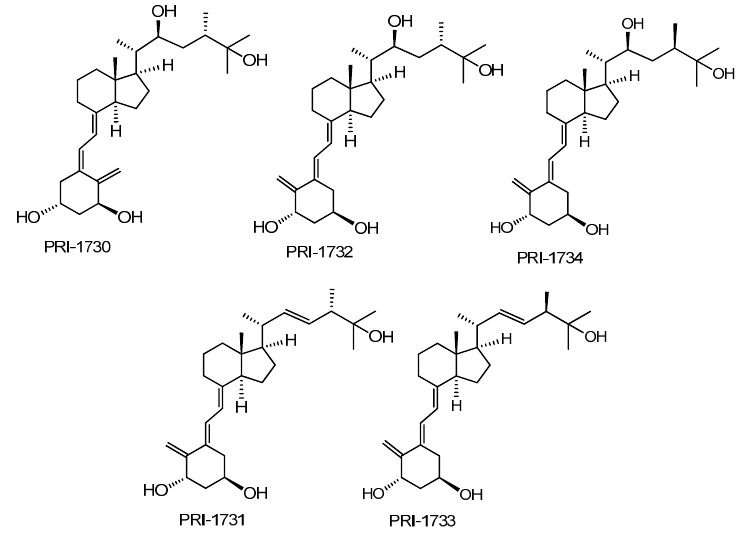
Figure 2. Structures of double point modified analogues of 1,25D 2 including 22-hydroxy analogues PRI-1730, PRI-1732 and PRI-1734, as well as analogue PRI-1731 with D 2 -like side-chain and its 24- epi analogue PRI-1733.